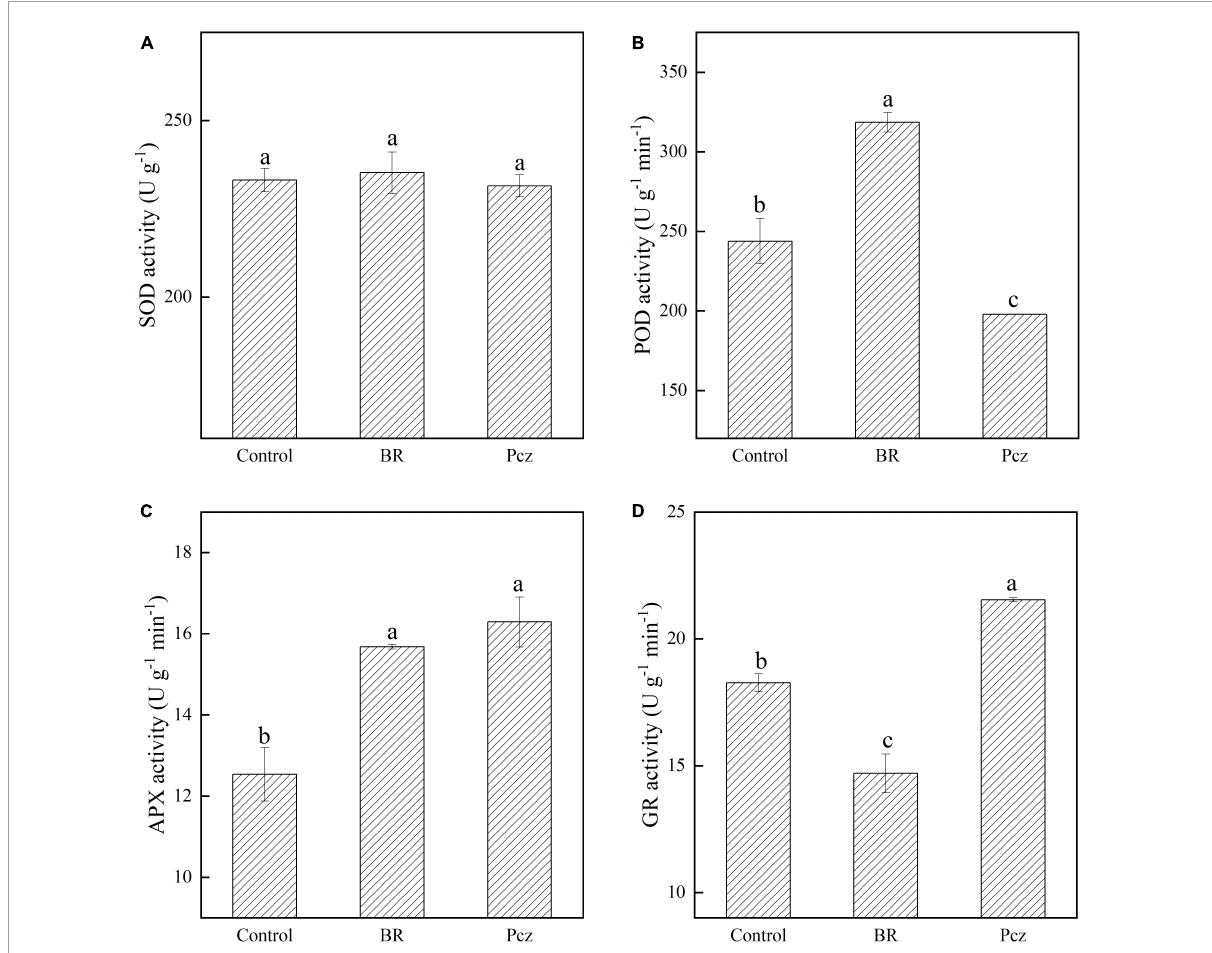
FIGURE2 Superoxide dismutase [SOD (A) ], peroxidase [POD (B) ], ascorbate peroxidase [APX (C) ], and glutathione reductase [GR (D) ] activity in bulbil of P. ternata under BR and Pcz treatments. The bars with different letters are significantly different from each treatment ( p < 0.05). Values are means of four replicates ±